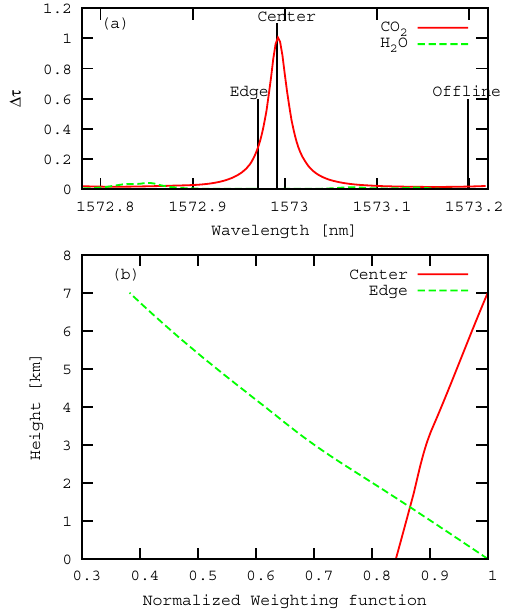
Fig. 1. (a) Operating laser wavelengths and CO 2 optical depth ver- sus wavelength and (b) vertical weighting function dependent on online wavelength. Both plots were calculated using the R(12) line parameters from HITRAN 2008 and some updated data for the two- way path from the ground to an altitude of 7km. Atmospheric pa- rameters are based on the Air Force Geophysics Laboratory (AFGL) mid-latitude winter. CO 2 mixing ratio is assumed to be 385ppm for all